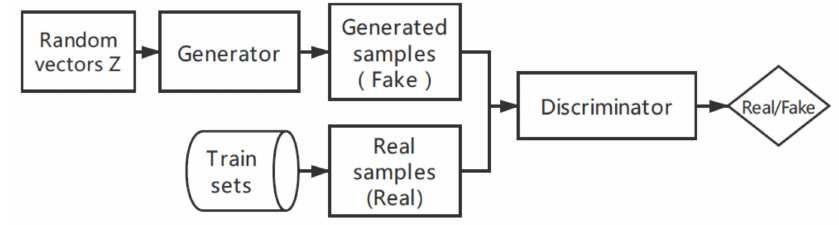
Figure 2. The typical structure of generative adversarial nets (GANs) adapted from